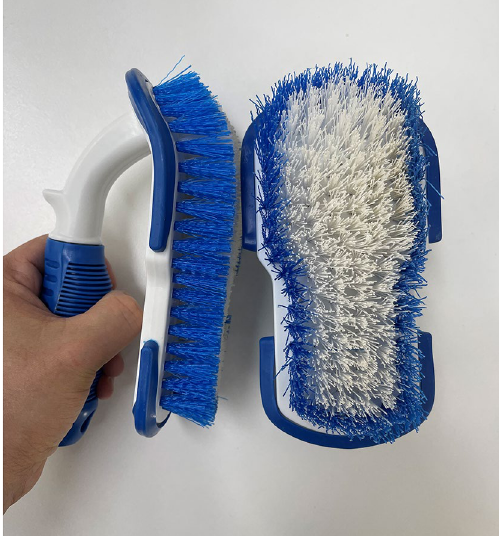
Figure 2. Durable handheld brushes selected for use in the